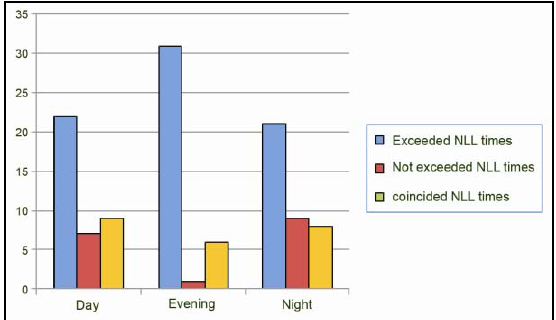
Fig. 30. The number of instances when the NLL was exceeded, non-exceeded and satisfied during all noise measurements in